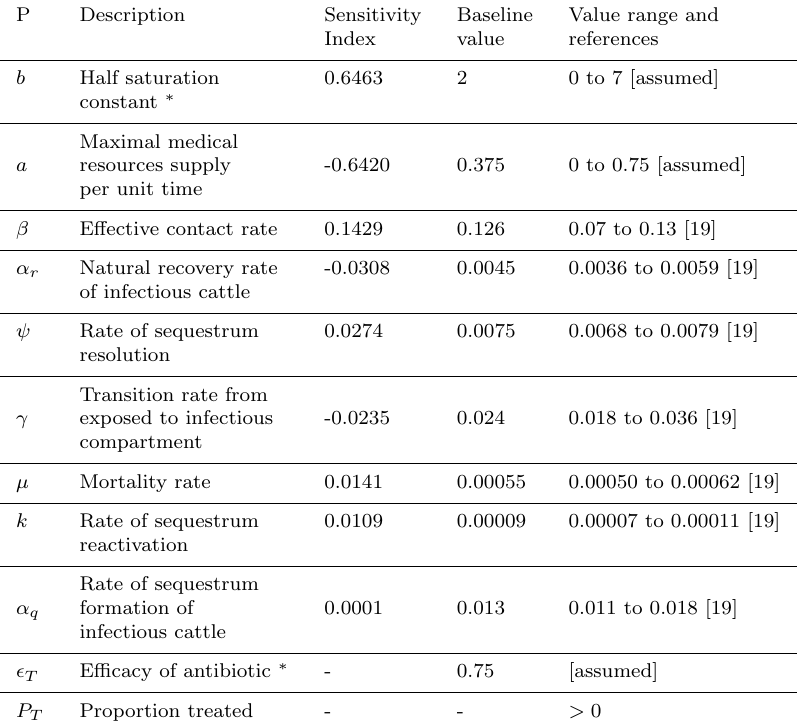
Table 3. Description of model parameters and their values with sensitivity index; indicating baselines, ranges and references. Units are days − 1 unless otherwise defined. ∗ constants. P: